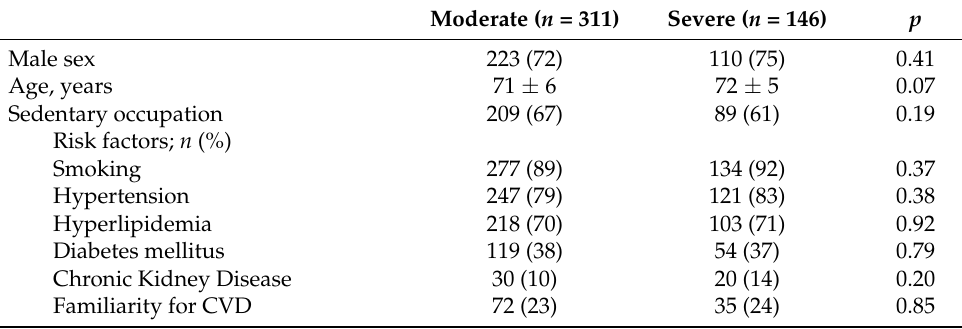
Figure 1. Flow diagrams of participants. Abbreviations: PAD, peripheral artery disease; ABI, ankle-brachial index. Table 1. Baseline characteristics of patients included in the